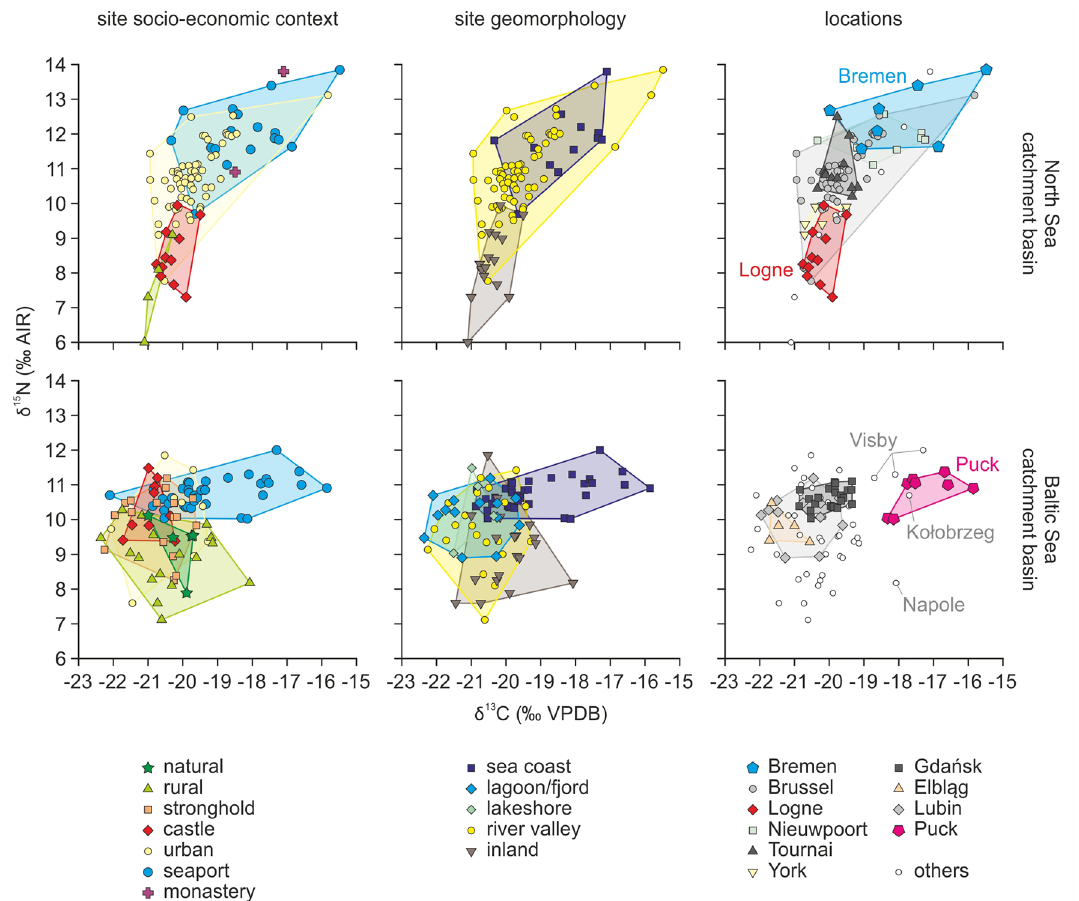
Figure 4. δ 13 C and δ 15 N values in cats vs. site socio-economic context, site geomorphology and locations (divided by sea catchment area). Colored fields are convex hulls covering samples attributed to each group. In locations panels, the locations that yielded < 5 specimens are denoted as